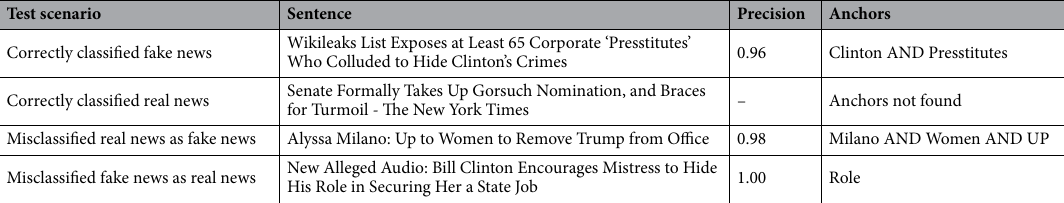
Table 5. Anchors explanations for the four test scenarios - Bidirectional LSTM